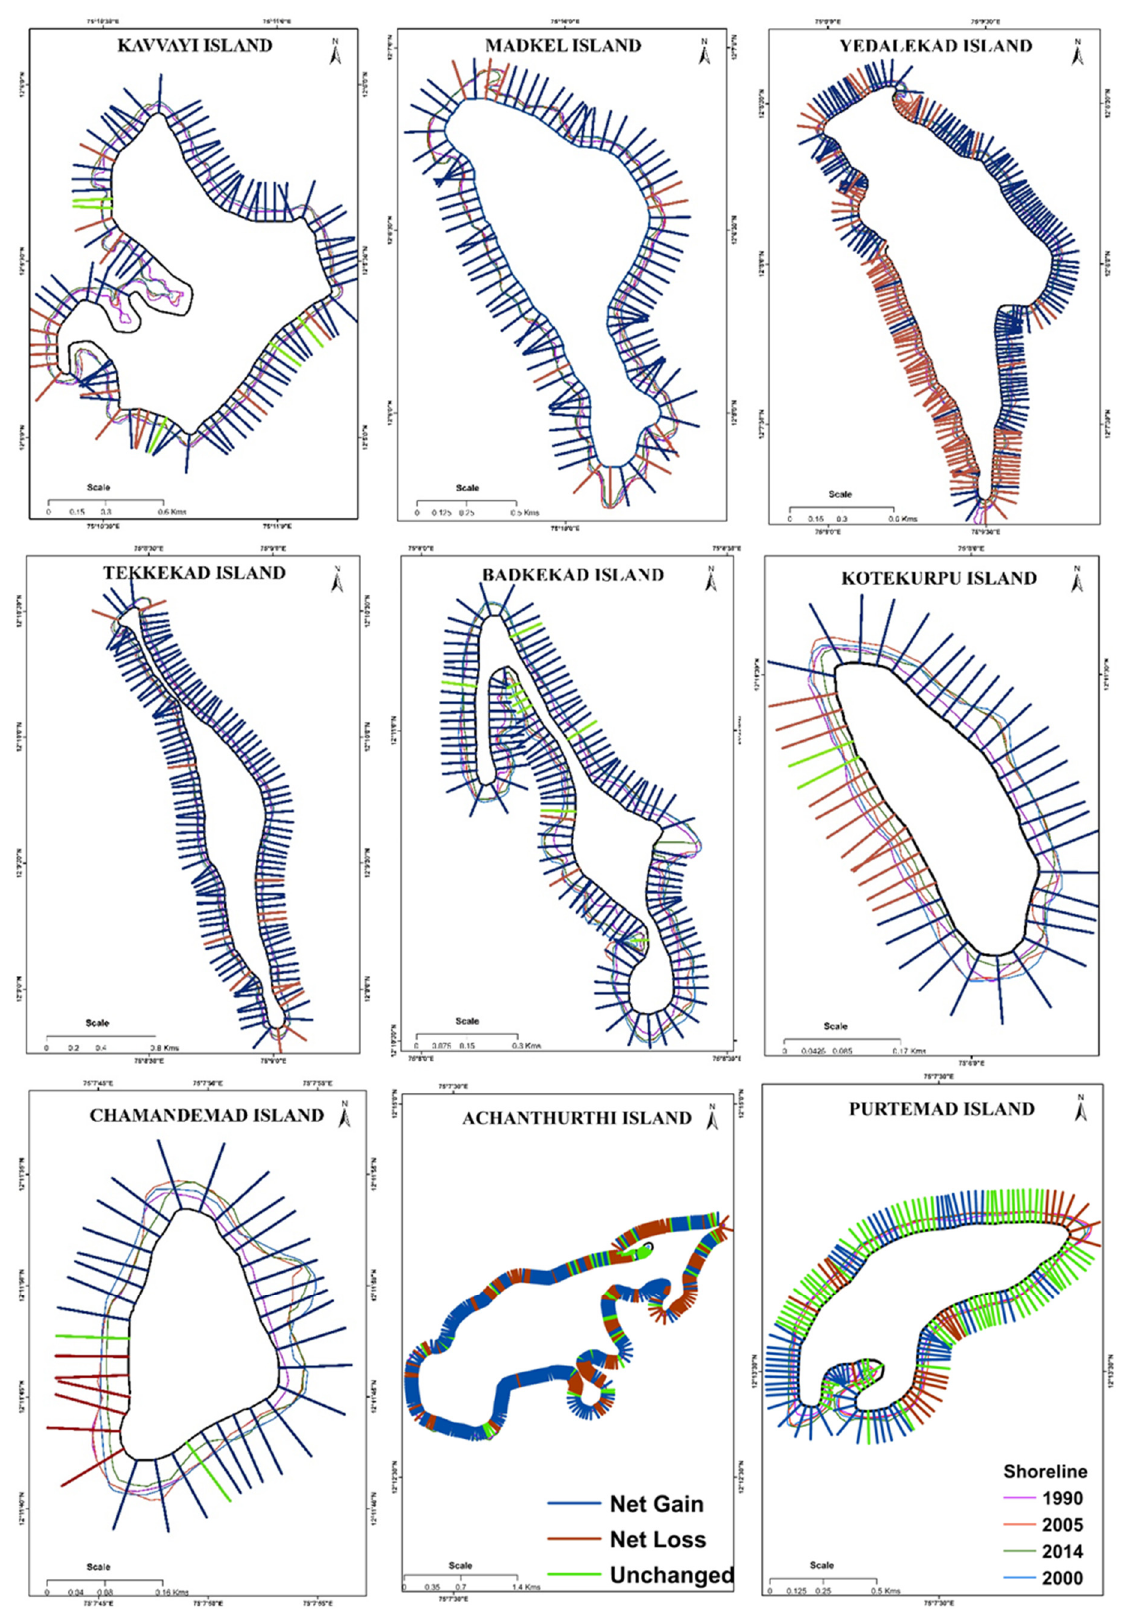
Figure 3. Net shoreline movement of nine beaches throughout the period of study from 1990 to 2014.